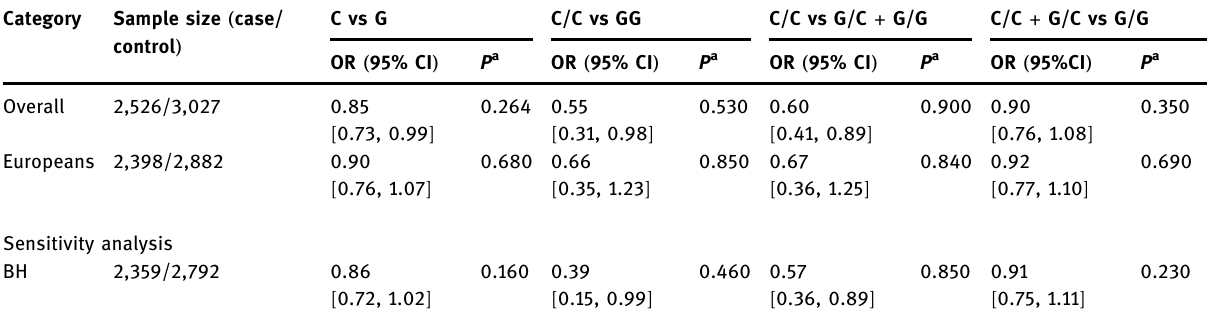
Table 2: Meta - analyses of IL - 6 gene − 572 G > C polymorphism and MI in each subgroup Category